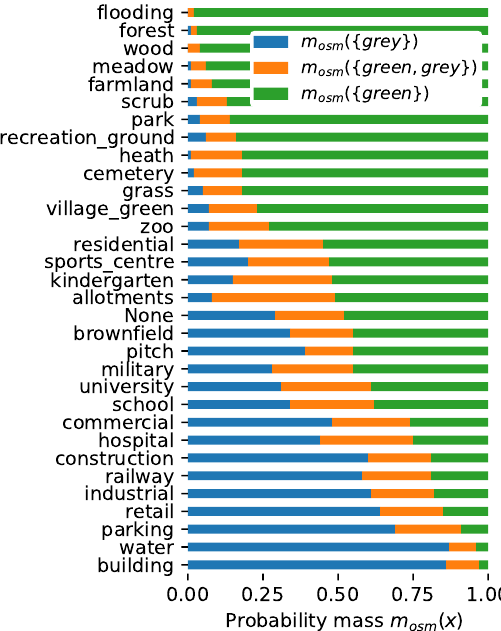
Figure 5. Probability masses for greenness based on land use related OSM